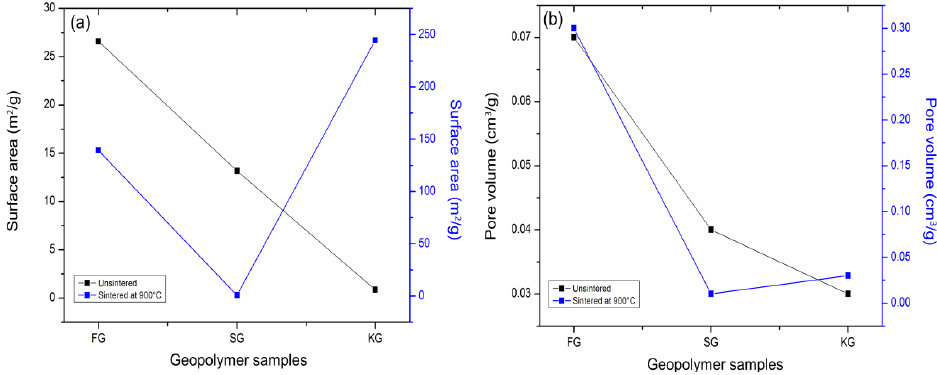
Figure 3. Pore structure of the geopolymer samples towards 900 ◦ C sintering temperature; ( a ) surface area and ( b ) pore volume.